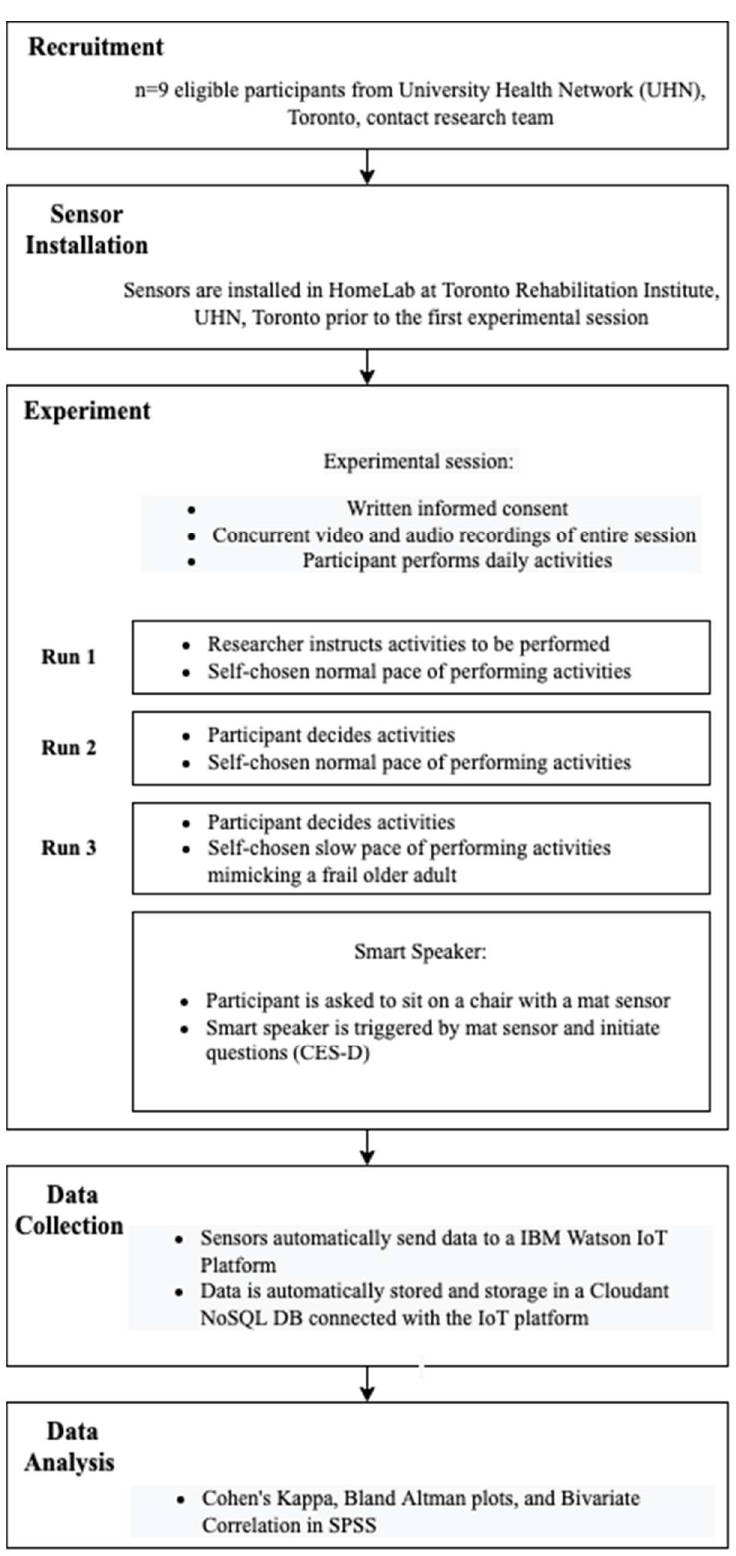
Figure 4. The schematized protocol for the experimentation.